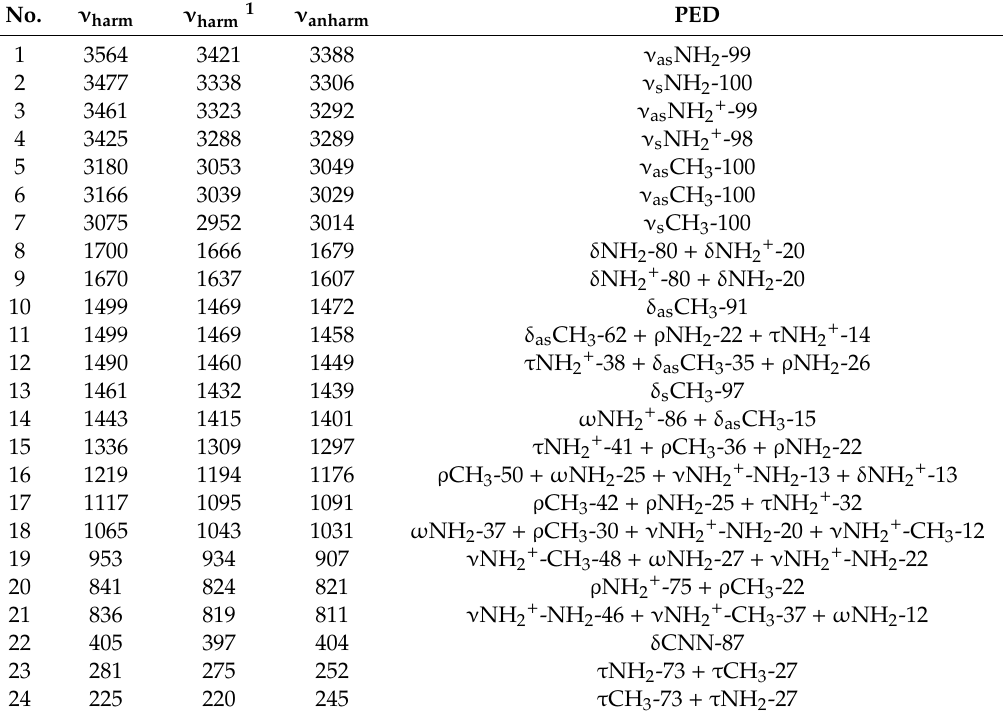
Table 1. Calculated (harmonic and anharmonic) wavenumbers for the MHy + cation.